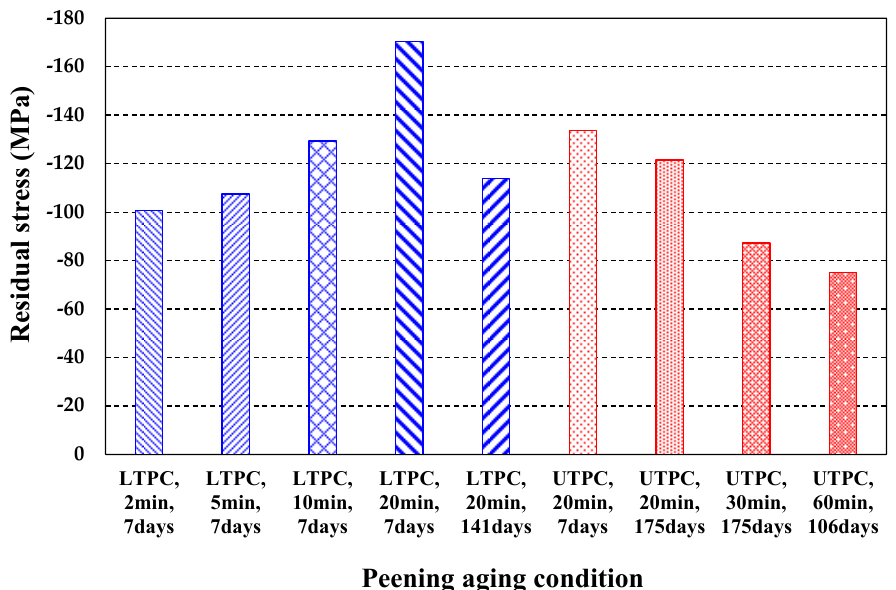
Figure 10. Aging variation of compressive residual stress of LTPC and UTPC.